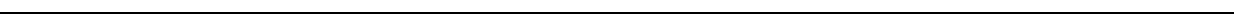
Fig. 11i for the depth of the optical sections; Supplementary Fig. 2b for the basolateral distribution of Wnt8-Myc). As shown by time-lapse confocal imaging in Xenopus embryos (Fig. 7a and Supplementary Movie 1), puncta of mV-Wnt8 on the cell membrane were internalized into the cell within seconds (cyan arrowheads), similar to an observation in zebra fi sh 48 . Internalized puncta of Wnt8-Myc mostly overlapped with N- sulfo-rich HS, but not with N- acetyl-rich HS (Fig. 7b, open arrowheads for no overlap and closed arrowheads for overlap).